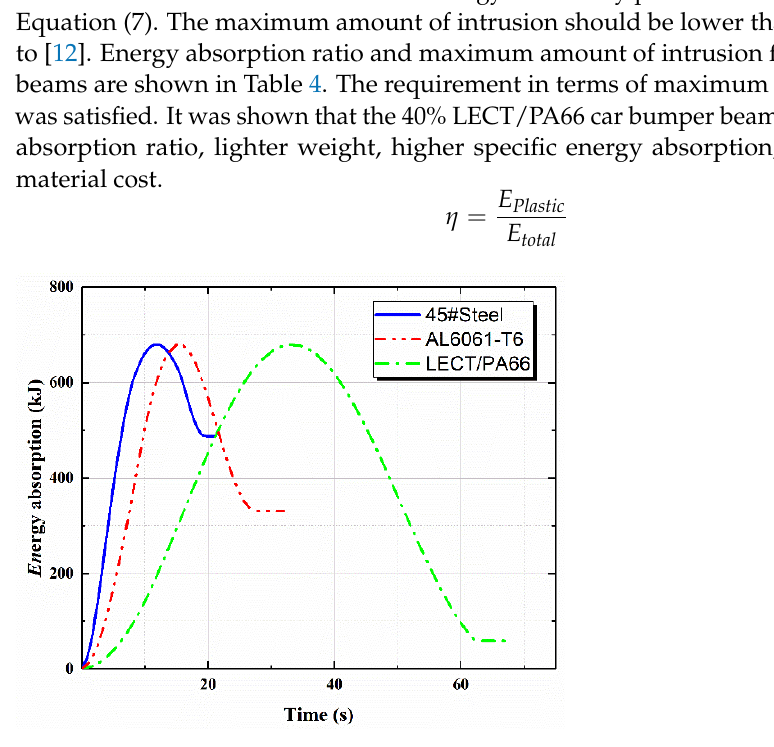
Figure 7. ( a ) Geometry of car bumper beam; ( b ) boundary condition of car bumper beam in ABA- BQUS.